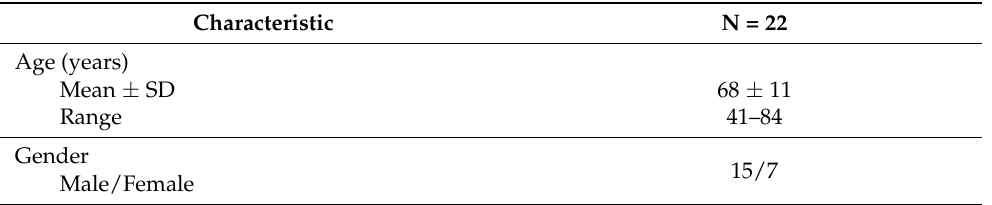
Table 1. Patient